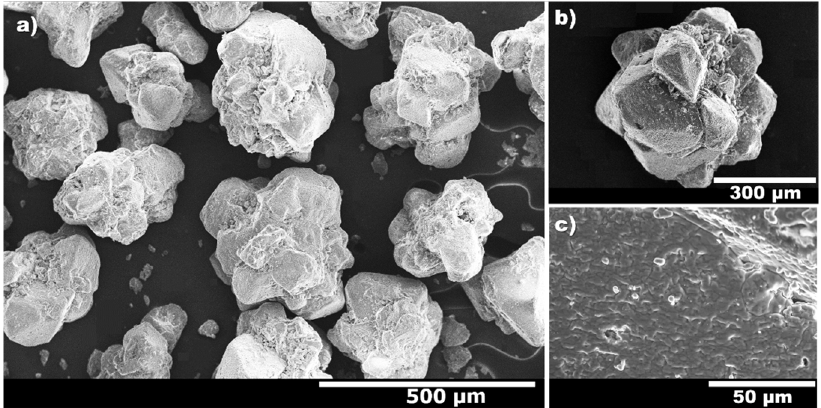
Figure 4. SEM images of K 2 SO 4 grains: ( a ) not coated grains; ( b ) grains with Ni and C-TiO 2 films; and ( c ) magnified image of the film.